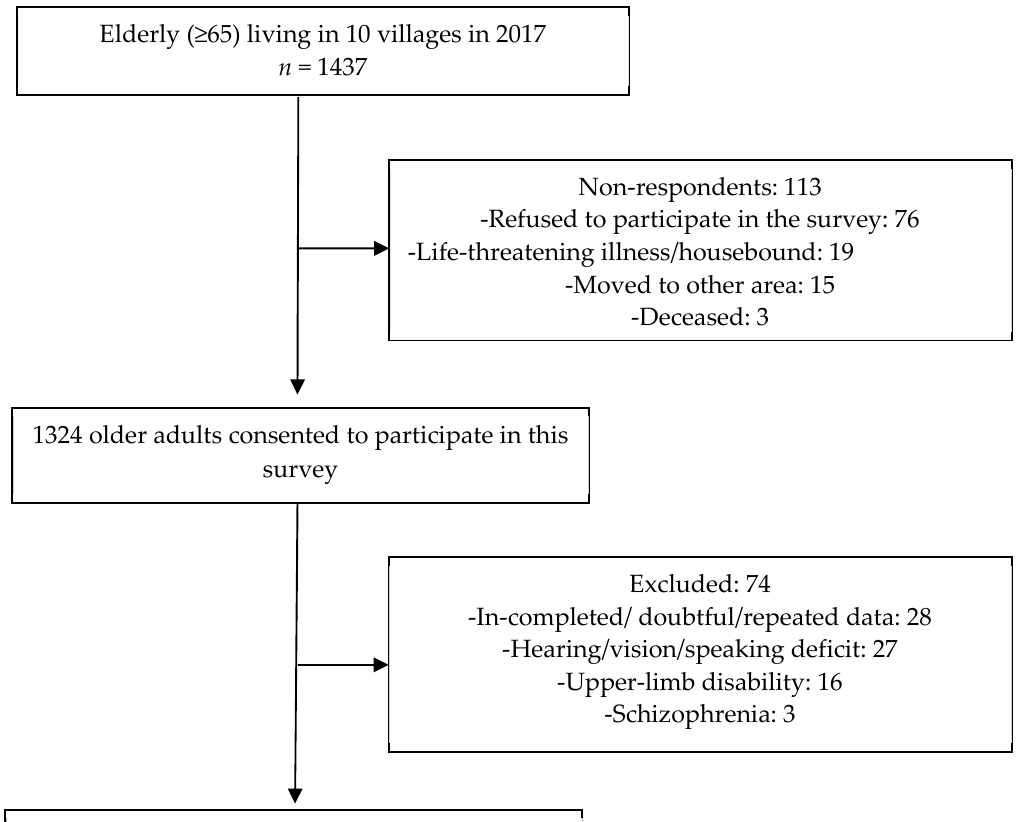
Figure 1. Flow of participants through the study.